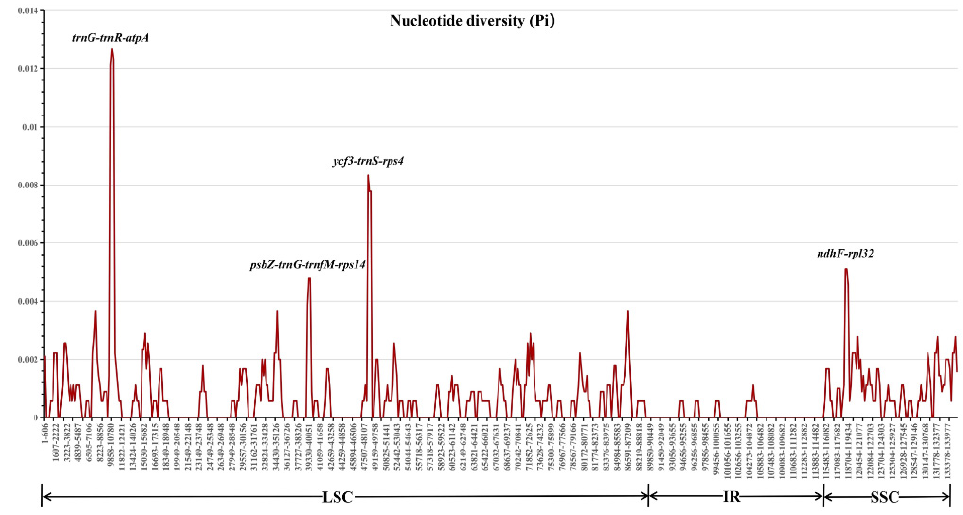
Figure 7. The nucleotide diversity (Pi) of six Pyracantha chloroplast genomes.